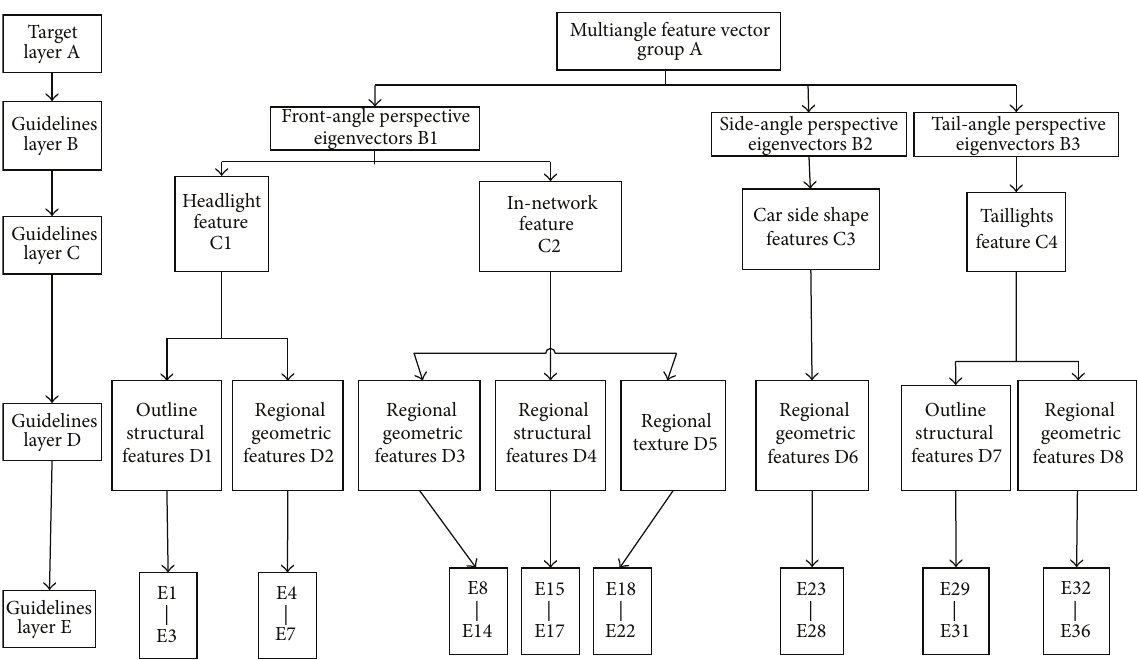
Figure 2: Multidimensional feature hybrid tree architecture based on